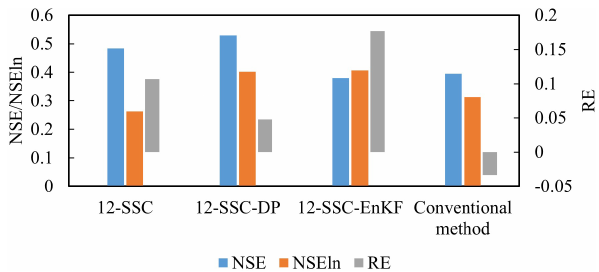
Figure 12. Simulation performance for streamflow in the Wuding River basin. The results of NSE and NSE ln are shown on the pri- mary axis, while the values of RE are shown on the secondary